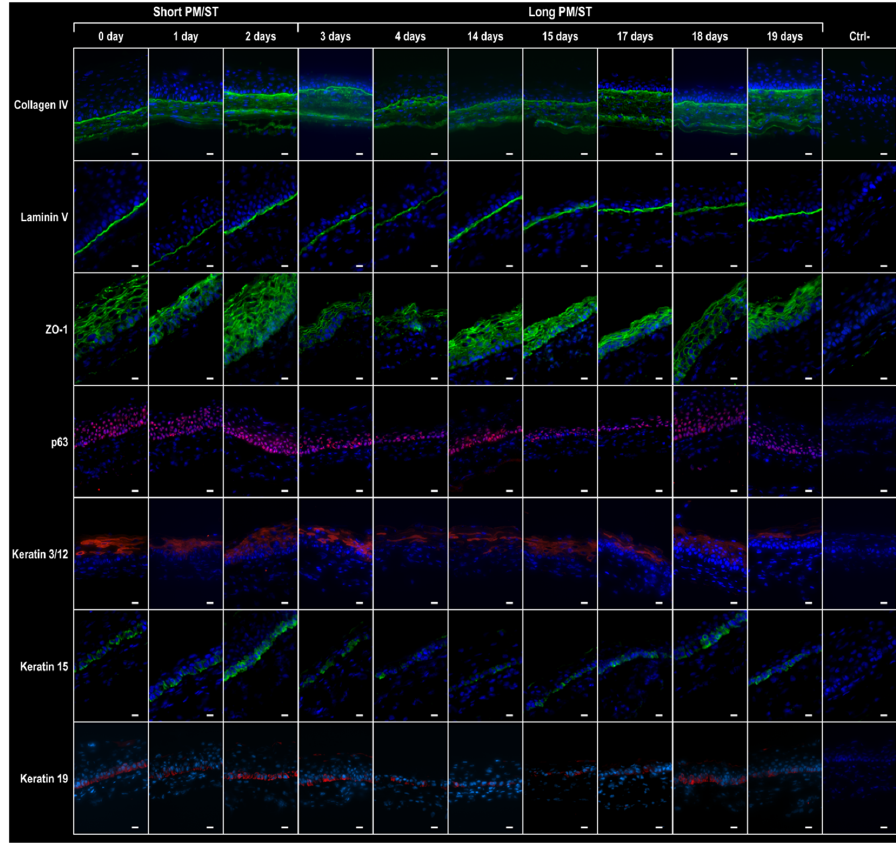
Figure 6. Immunofluorescence analysis of human-tissue-engineered corneas (hTECs) produced us- ing hLECs with short and long PM/ST. Human-tissue-engineered corneas (hTECs) were reconstructed by seeding hLECs with various PM/STs over reconstructed stroma to produce a 3D construct. Immunofluorescence staining of epithelial basement membrane components (collagen IV and laminin 5), corneal epithelial cell junctions (ZO-1) epithelial tissue development regulator (p63), differentiation marker for corneal epithelial cells (K3 and K12), and poorly differentiated corneal epithelial cells (K15 and K19) in both SPM/ST hTECs (short PM/ST: 0, 1, and 2 days) and LPM/ST hTECs (long PM/ST: 3, 4, 14, 15, 17, 18, and 19 days). Ctrl-: immunofluorescence without primary antibody. Scale bar: 20 μ m.